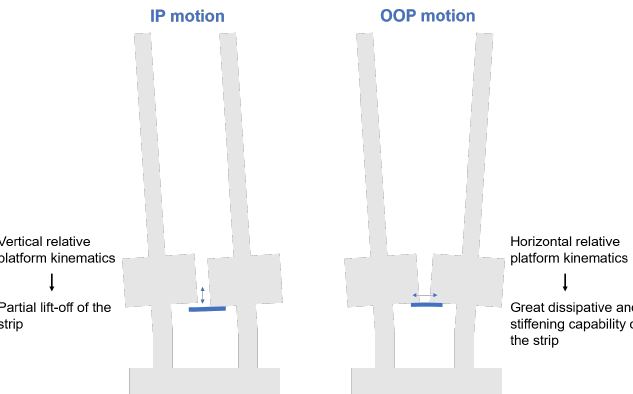
Figure 5. IP and OOP blades’ mode shape of vibration and corresponding strip